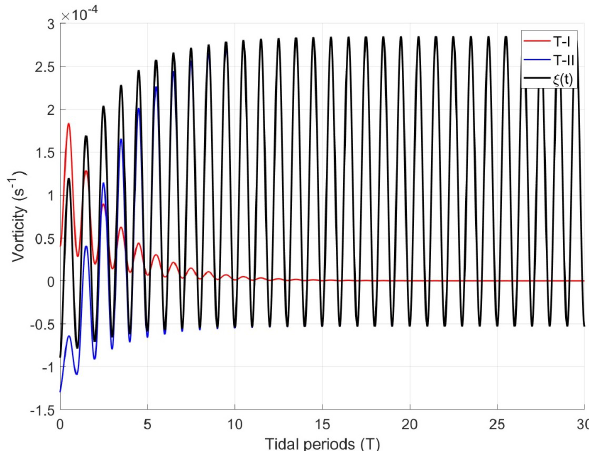
Figure A1. Vorticity evolution of a water column forced to oscillate over a linear bottom slope, for ξ 0 = 0, H 0 = 500m , α = 0 . 1, A = 0 . 5ms − 1 , ω = 1 . 4 × 10 − 4 rads − 1 (for M2) and R = 0 . 003ms − 1 . The red line is the transient solution (term T-I in Eq. A6), the blue line is the statistically steady solution (term T-II), and the black line is the full